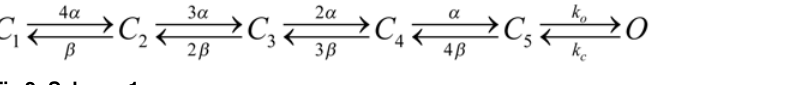
Table 1. Kv model for Schemes 1 and 2( * ) (as presented in Fig. 4 of Ref. [36] and Figure 11 of Ref. [39]). α 0